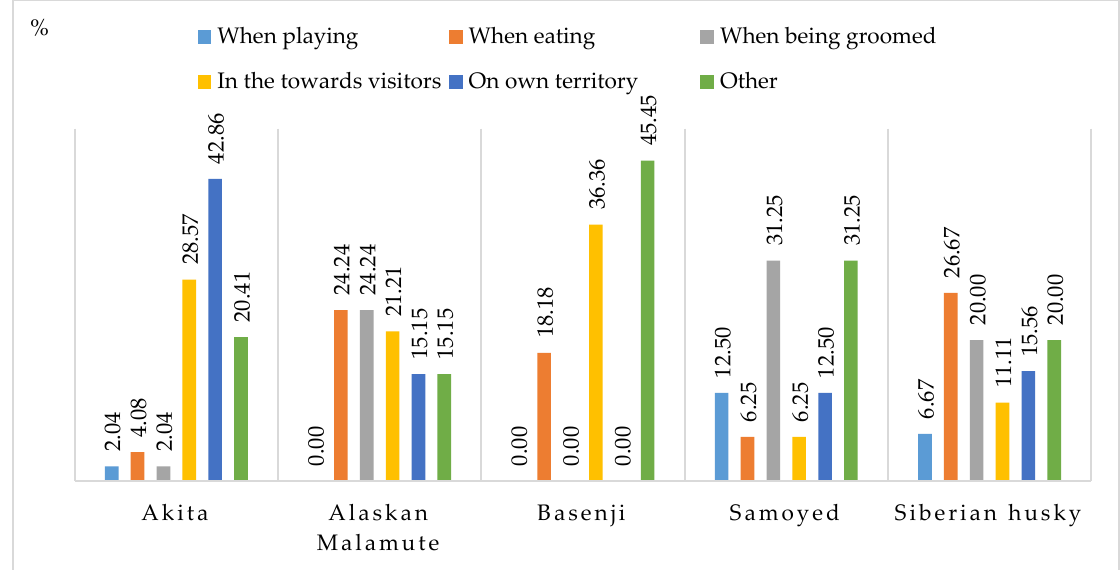
Figure 5. Situations that elicit an aggressive response towards humans (%). Problematic behaviors that could indicate separation anxiety included vocalization, elimination in the house, damaging furniture and other objects, scratching doors and windows, and other (Figure 6). The most prevalent behavioral problems in this category were vocalization (from 27.42% in Siberian huskies to 50% in Alaskan Malamutes) and damaging furniture and other objects (from 11.76% in Alaskan Malamutes to 47.73% in Basenjis). According to the respondents, other behaviors indicative of separation anxiety were observed in early life. These problems disappeared after training and when dogs became accustomed to being left alone at home or in the backyard. Undesirable motor activities included self-chewing, excessive licking, tail chasing, running along the fence line, chasing cars, and other (Figure 7). The first three behaviors were most often reported in the survey. They were least prevalent in Basenjis, where car and bicycle chasing was most frequently reported (46.15% of the cases). Other undesirable behaviors included hunting, spinning or chewing on the leash during